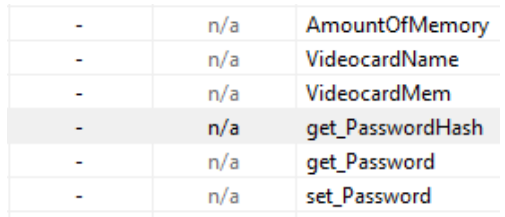
Figure 6. Malicious functions used in malware sample.